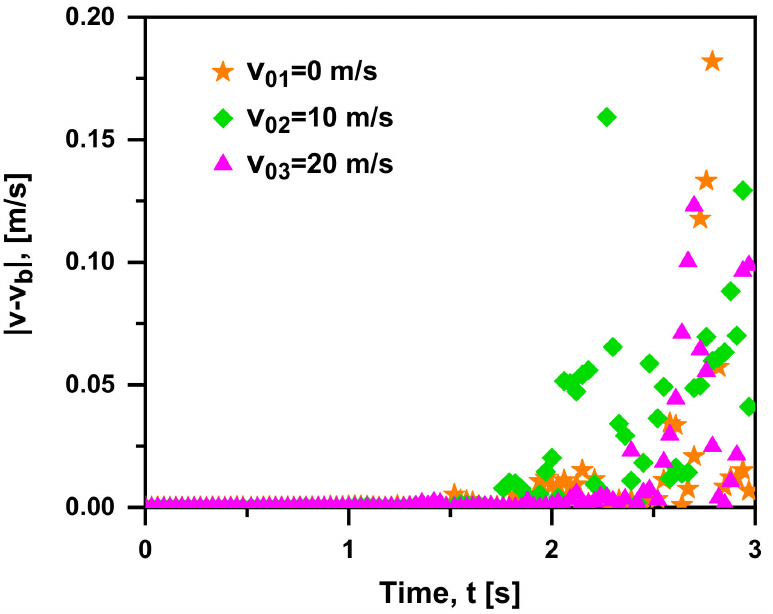
Figure 7. Absolute difference in rising velocity between the case with and without Basset force at three initial velocities ( d b = 1 mm, ρ f = 1000 kg/m 3 , ρ b = 1.29 kg/m 3 in quiescent